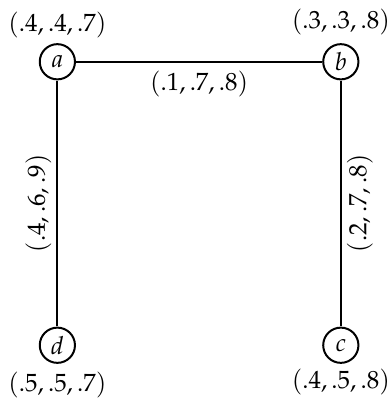
Figure 6. Neutrosophic